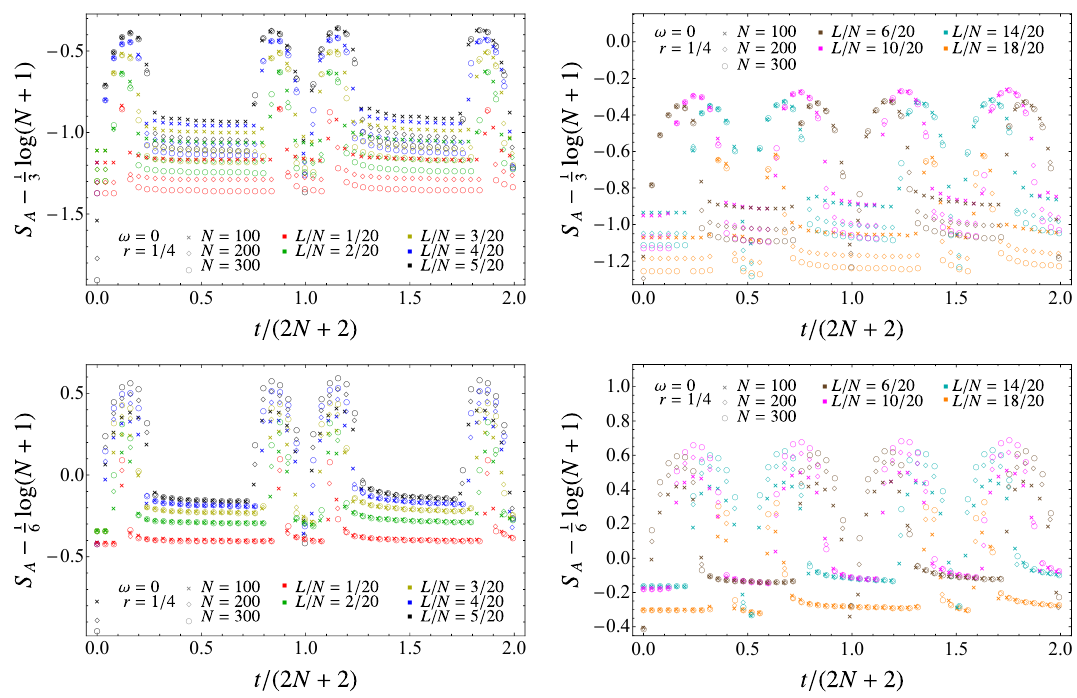
Figure 9 . Temporal evolution of the entanglement entropy S A in the same setup described for figure 8. The size of the blocks is L 6 rN in the left panels and L > rN in the right panels.